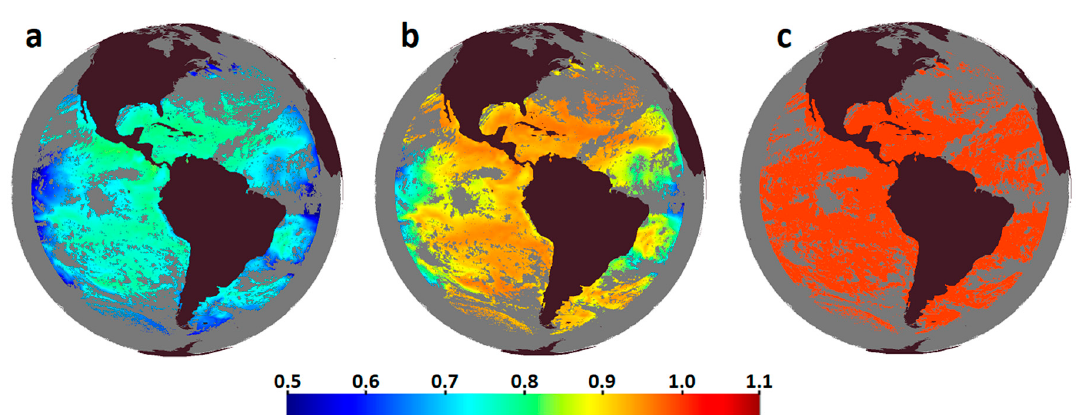
Figure 6. Images of the sensitivity of GOES-16 ABI SST for ( a ) GR-IS SST, ( b ) GR-L4 SST, and ( c ) PWR-L4 SST at 20:00 UTC 1 March 2018.